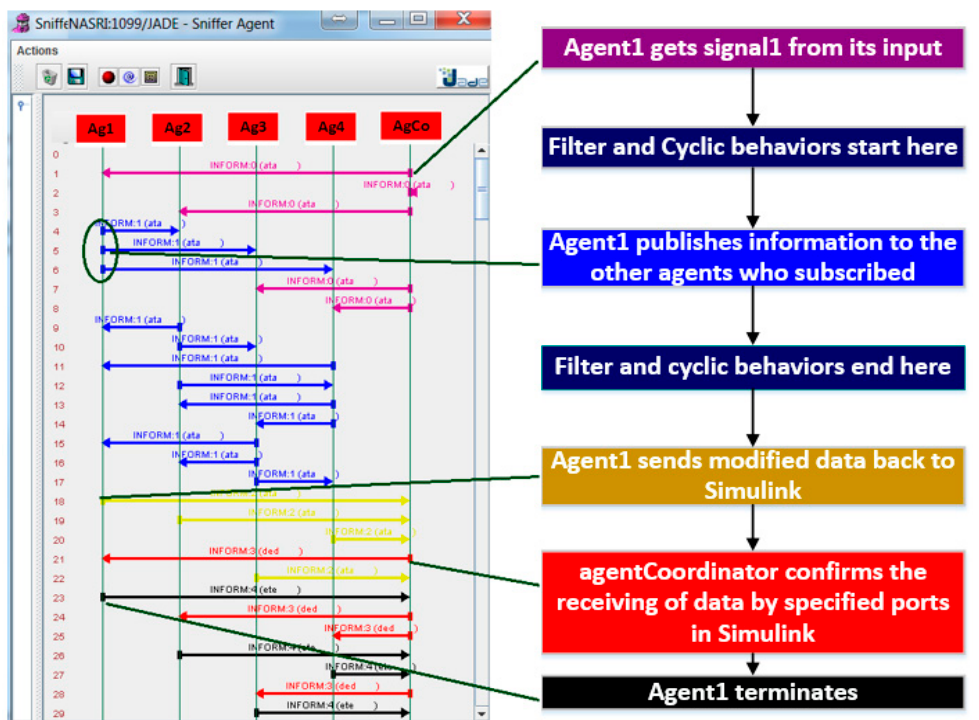
Figure 10. A snapshot of the JADE (Java Agent DEvelopment Framework) platform while running message exchange among agents.